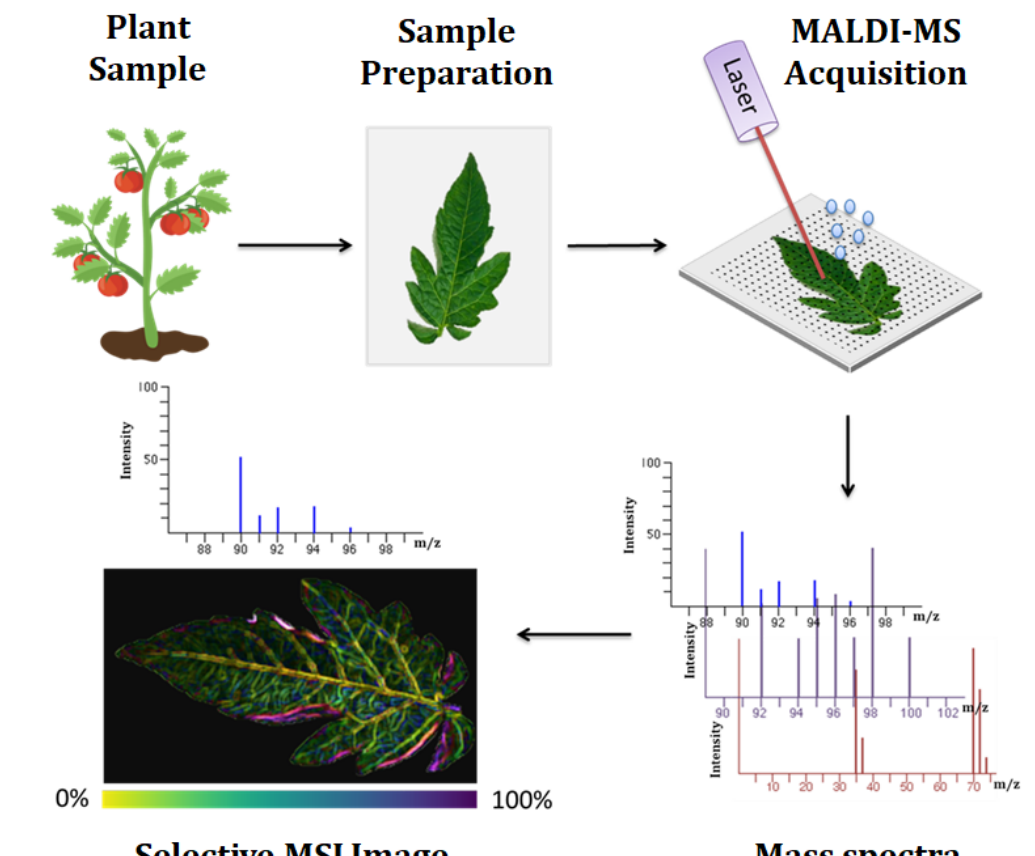
Figure 2. A general overview of a matrix-assisted laser desorption/ionization-mass spectrometry imaging (MALDI-MSI) workflow. A tissue (leaf) is sectioned from the sample (tomato plant) and mounted on a target surface. A matrix is applied to the tissue and a laser beam extracts metabolites into a mass analyzer. Mass spectra are generated at each x , y coordinates across the tissue surface. A software algorithm combines and processes the mass spectra and generates a MSI image.